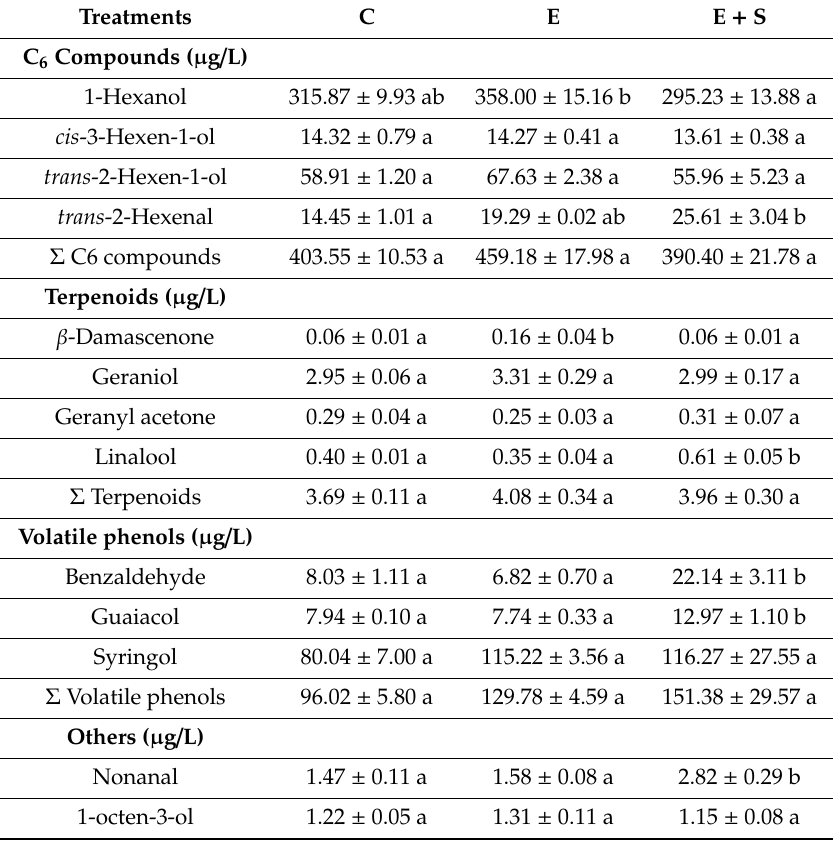
Table 2. Volatile compounds determined in Bobal grapes on harvest